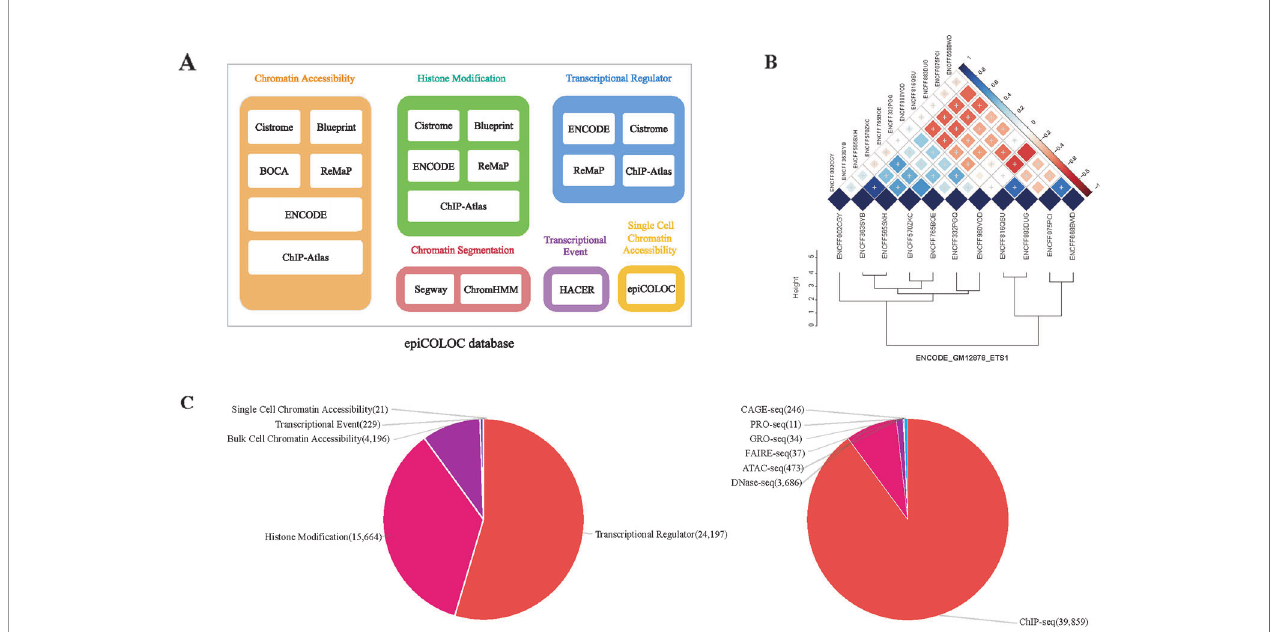
FIGURE 1 | The overview of epiCOLOC design and datasets. (A) The source schema of epiCOLOC data collection. (B) An example to illustrate outlier pro fi les removing. (C) The summary of data types in the current version of